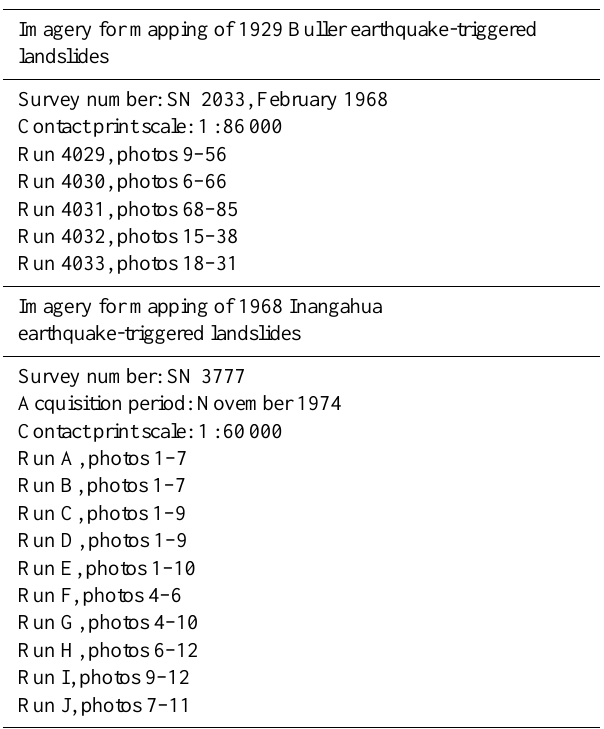
Table A1. Source and details of imagery used for landslide mapping for the 1929 and 1968 earthquakes.